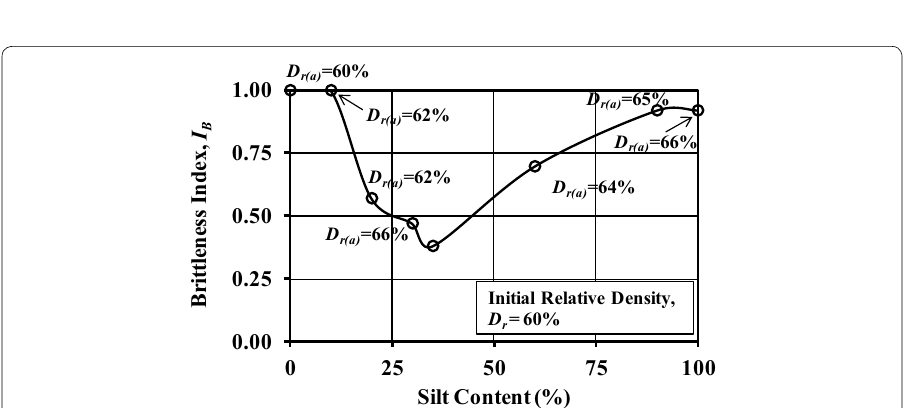
Fig. 14 Brittleness index of sand–silt mixtures at initial relative density, D r